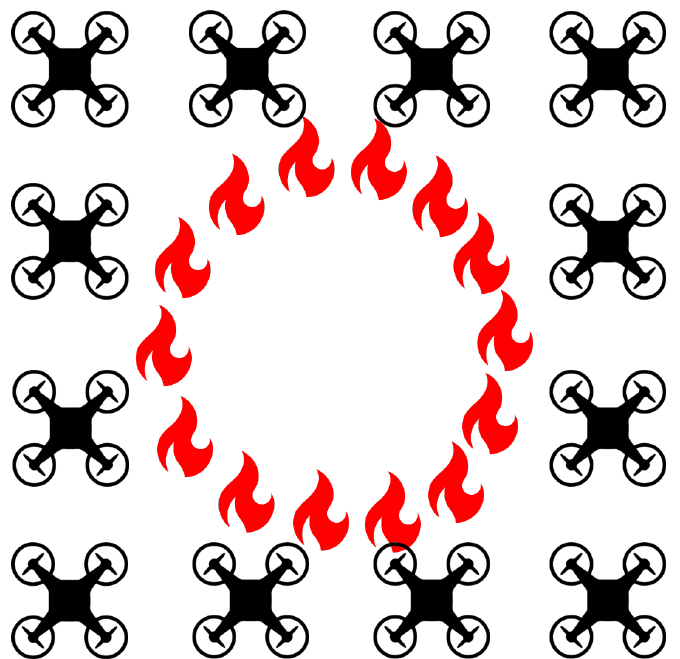
Figure 2. Action in square formation in front of a fire with a circular